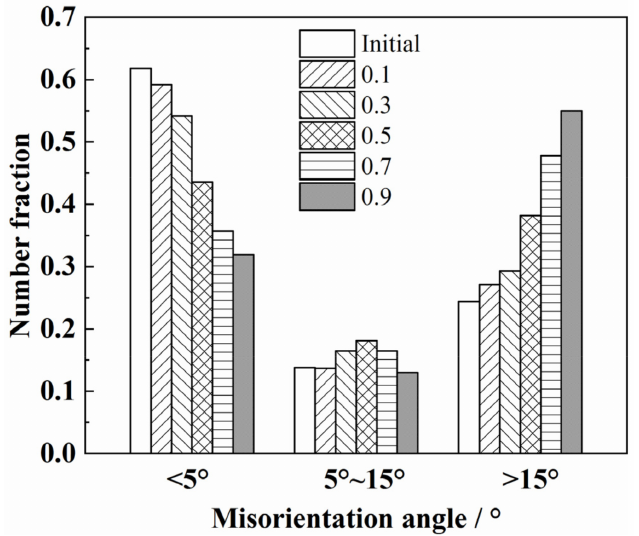
Figure 14. The evolution of the misorientation angle at different strains when deformed at 950 ◦ C and 0.01 s − 1